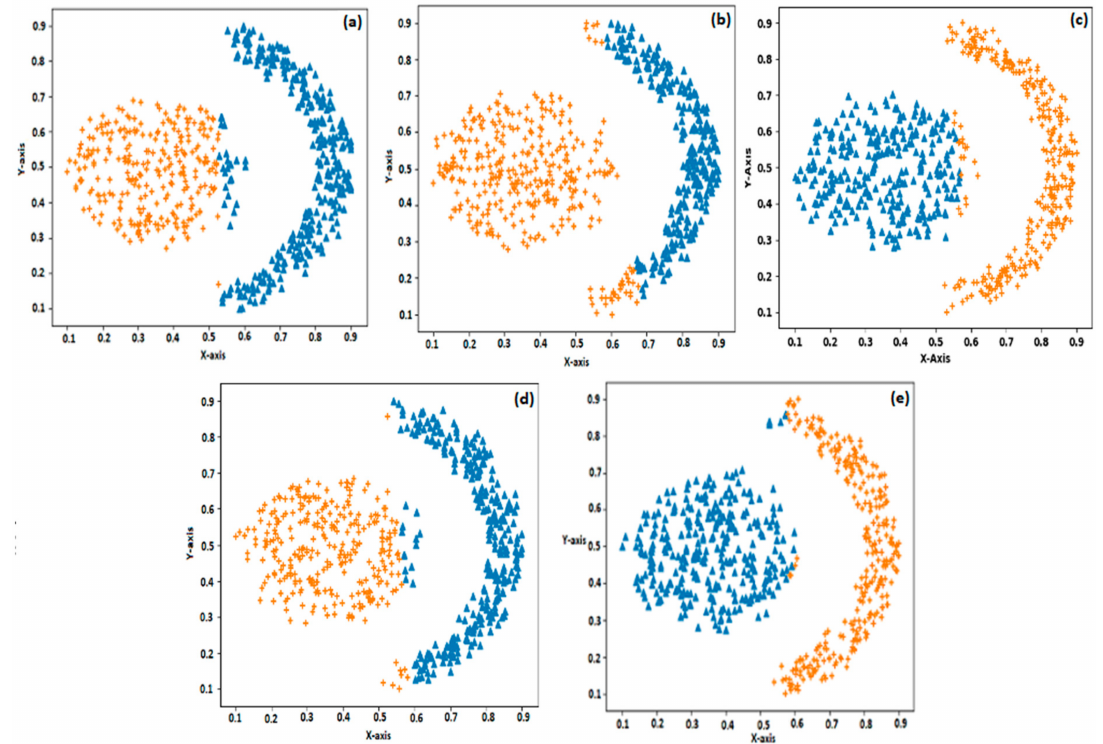
Figure 3. Clustering of flame pattern distribution using ( a ) k-means; ( b ) SOM; ( c ) EM; ( d ) US-ELM; and ( e ) BELMKN.